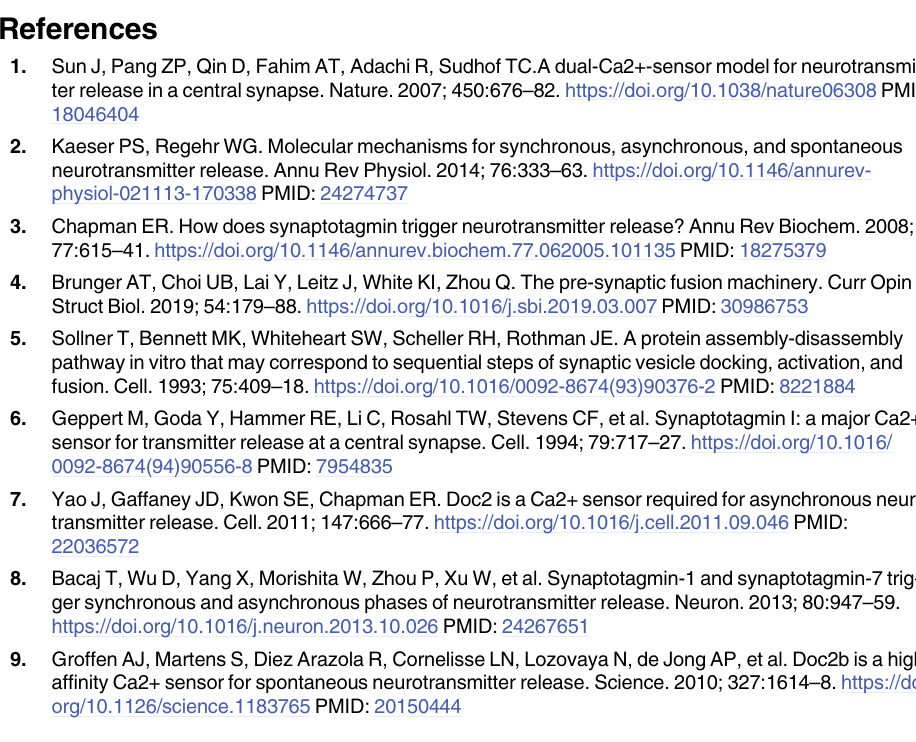
S1 Data. Numerical data underlying Figs 1–4 and S1–S8. Excel spreadsheet containing in separate sheets the numerical data underlying Figs 1–4 and S1–S8, respectively. (XLSX) S1 Raw images. Uncropped western blots data related to Figs 3B and S4A and S4B.